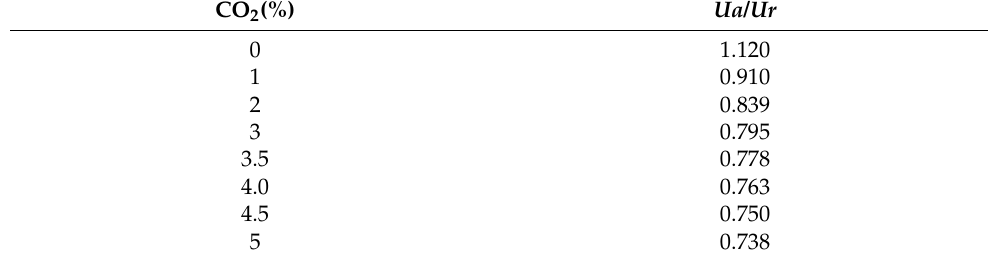
Table 1. Voltage ratio at different CO 2 concentrations.